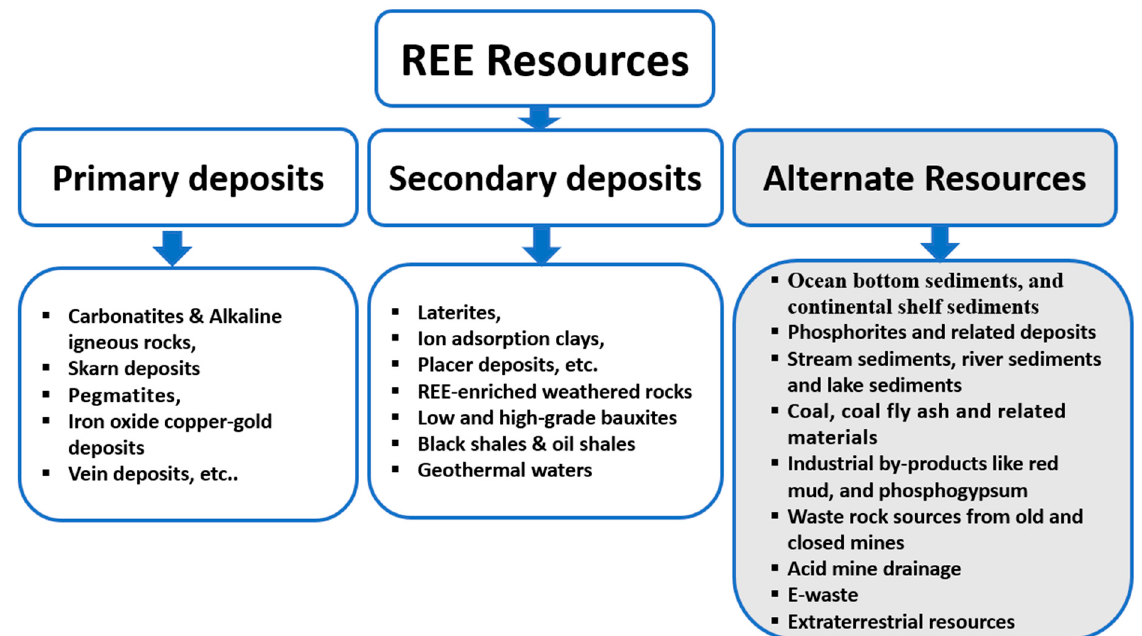
Figure 1. Illustrative view of different types of REE resources, including the potential alternative future resources shaded in light color [14].